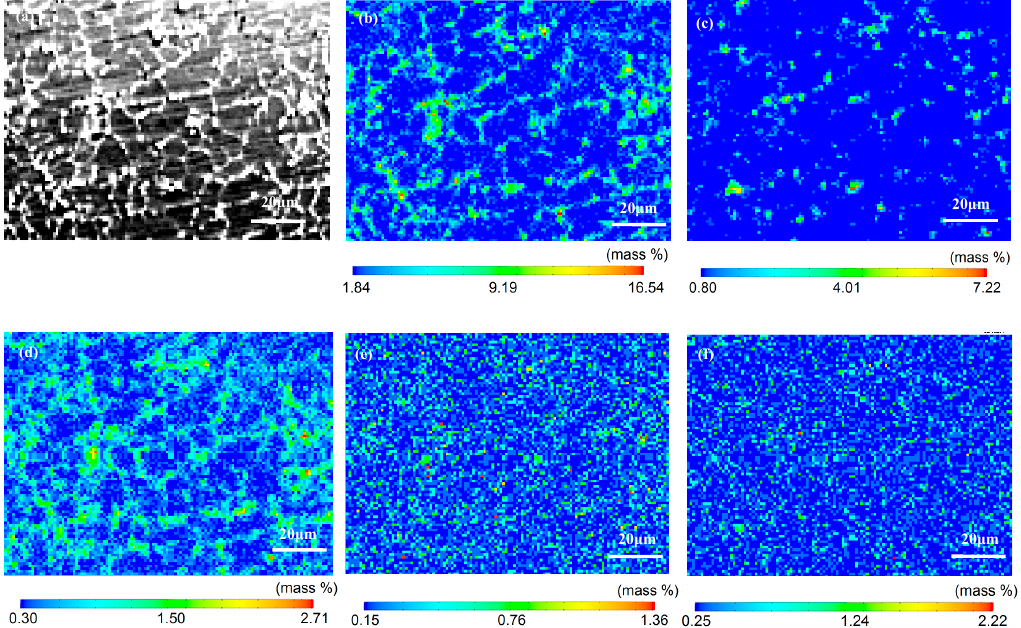
Figure 2. Electro-Probe Microanalyzer (EPMA) analysis of the chemical compositions of the weld metal in the 2060 Al–Li alloy laser welding joint. ( a ) microstructure of the fusion zone; ( b ) distribution of Cu; ( c ) distribution of Si; ( d ) distribution of Mg; ( e ) distribution of Ag; ( f ) distribution of